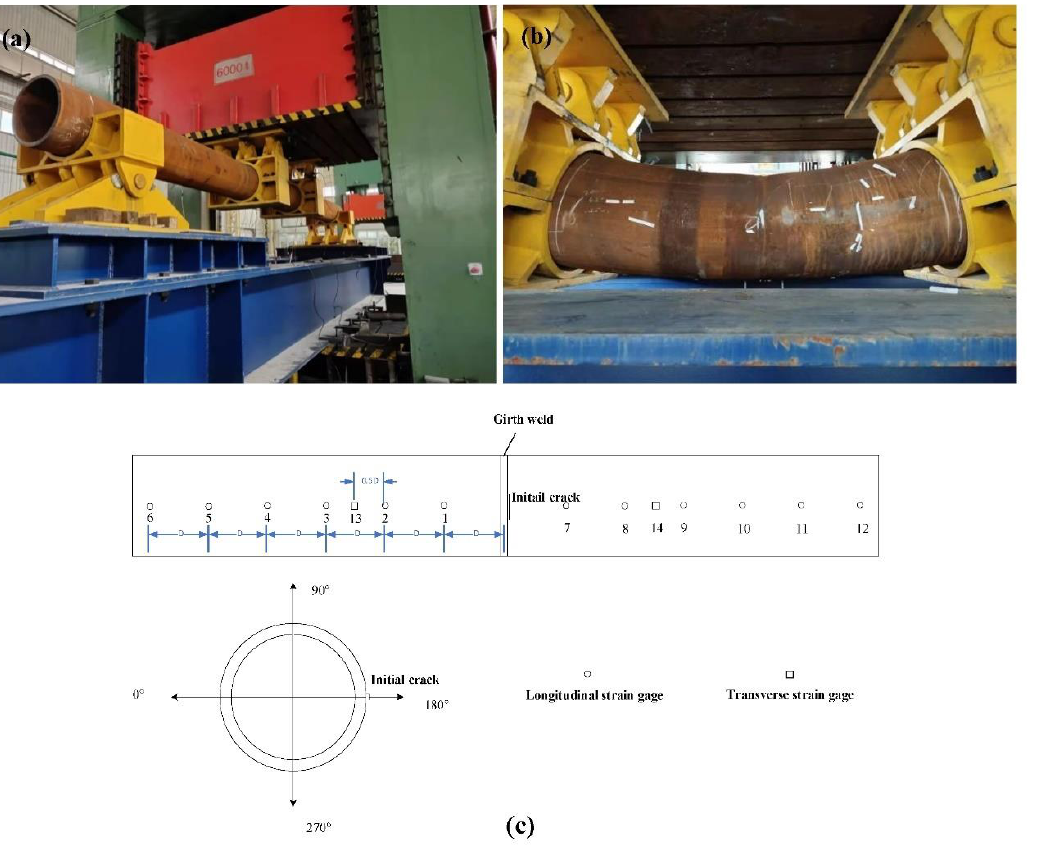
Figure 14. Full-size bending test for the high-strain marine pipe. ( a ) Test setup; ( b ) Bending area of the pipe; ( c ) Diagram of strain gauge positions on the pipe.